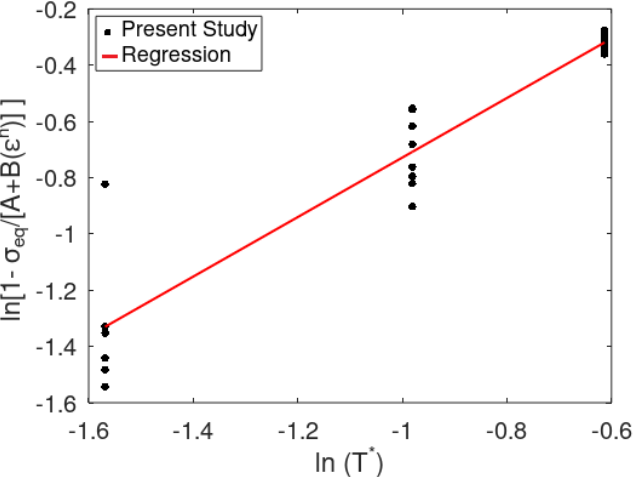
Figure 4. Curve fitting of true plastic stress-strain values at different temperatures to obtain m .